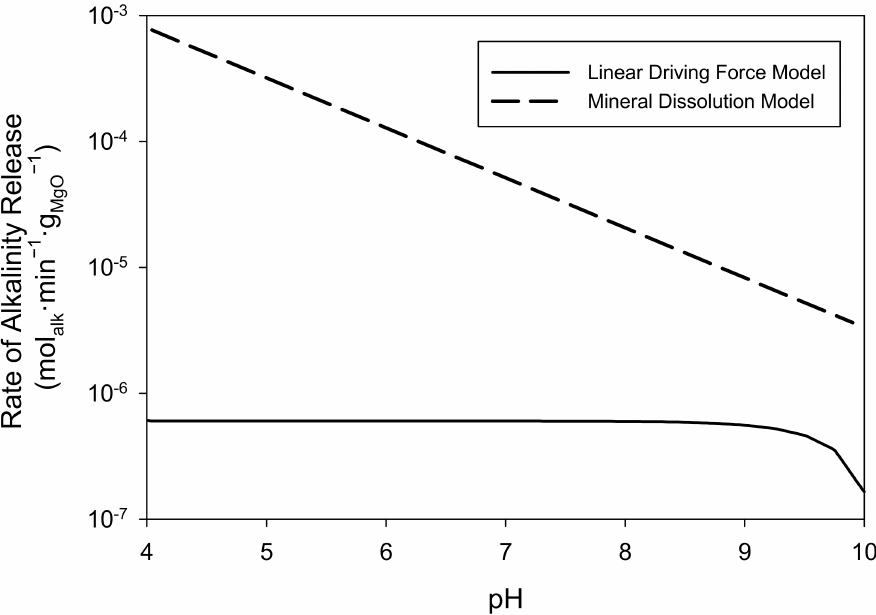
Figure 7. Comparison of the mineral dissolution model used to describe rates of alkalinity release from aqueous suspensions of particles and the linear driving force model used to describe rates of alkalinity release from particles encapsulated in the oil droplets of an oil-in-water emulsion. Note that the release rates are shown on a log